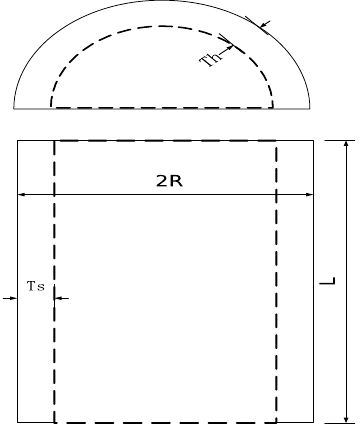
Figure 16. Schematic of pressure vessel.